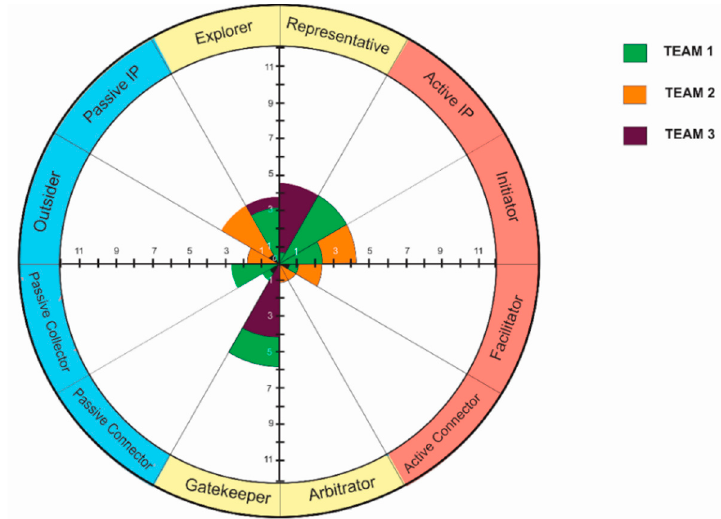
Figure 8. Example of collective role profiles for several teams.